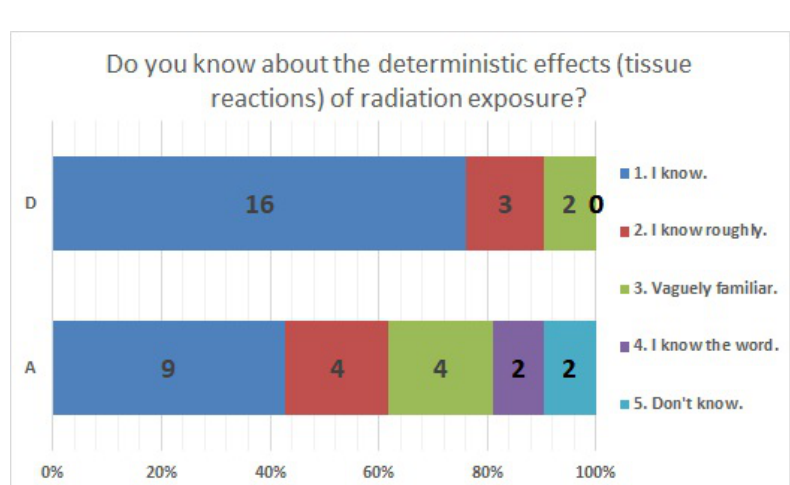
Figure 22. Responses to item No. 36.